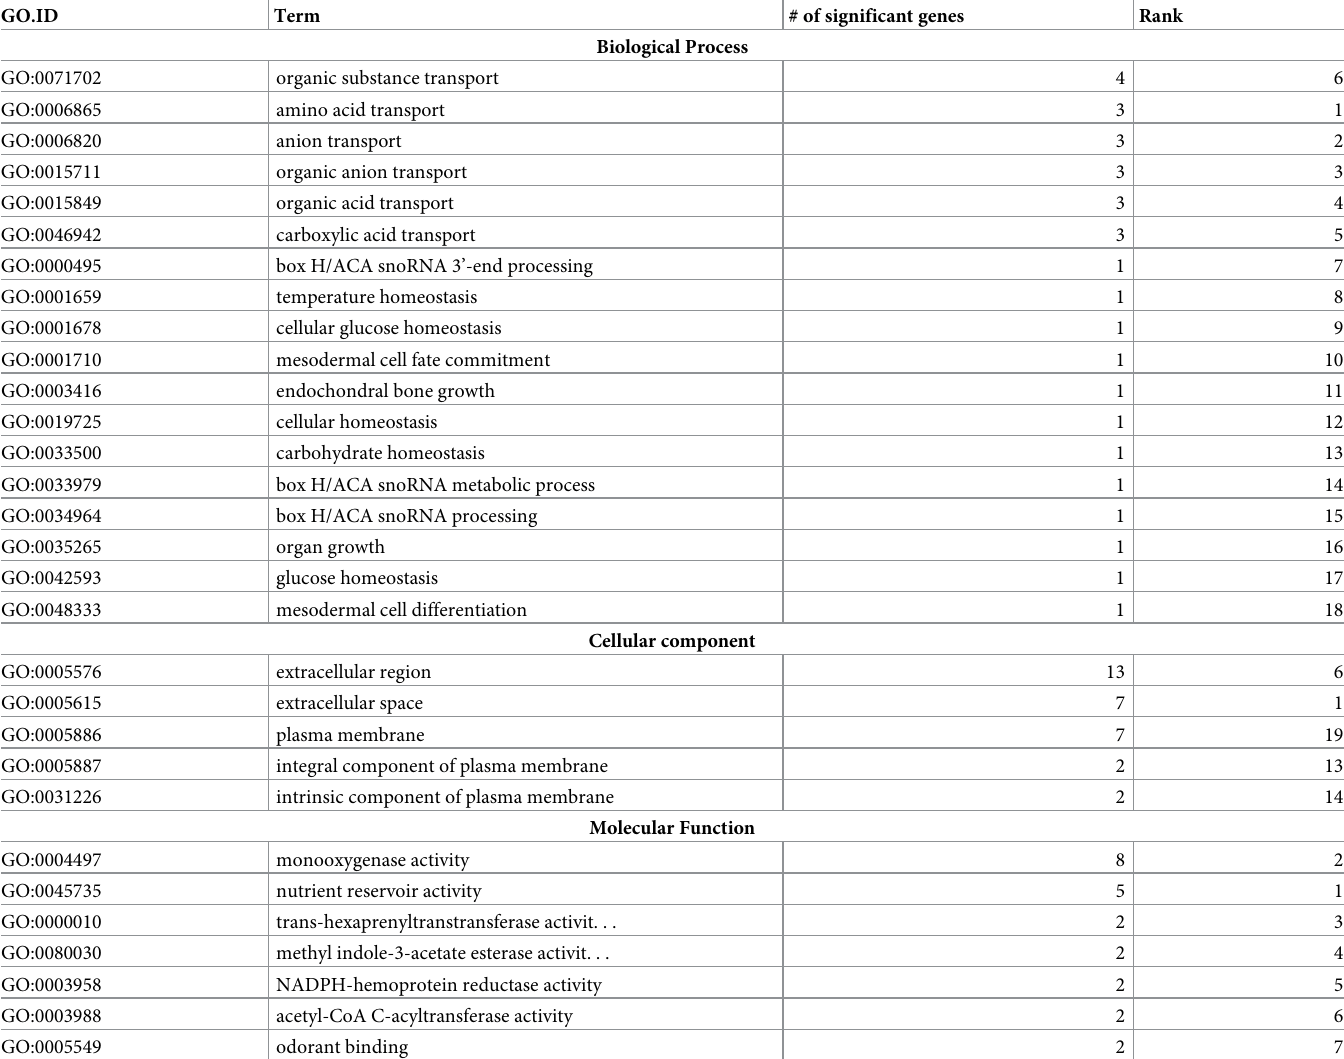
Table 3. Enriched GO terms in the set of 651 differentially expressed